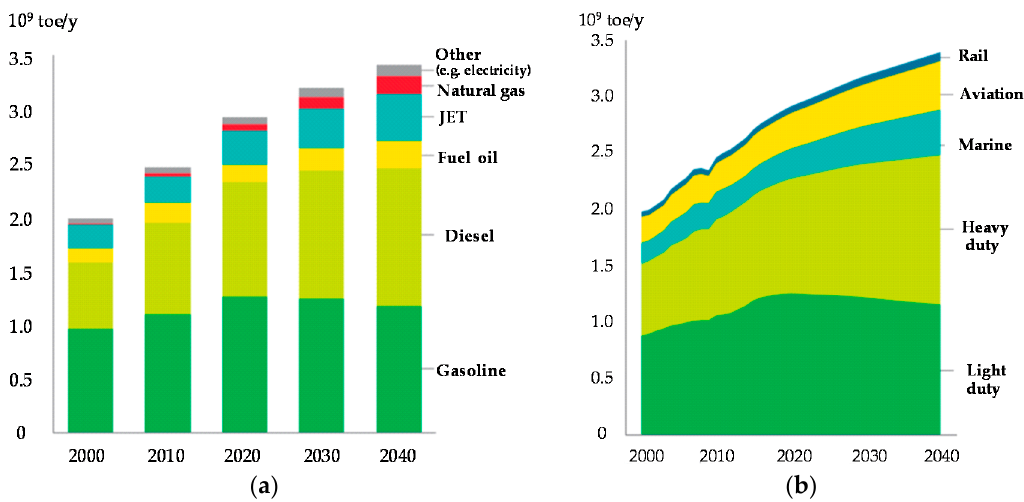
Figure 1. Light-duty vehicles by fleet type.